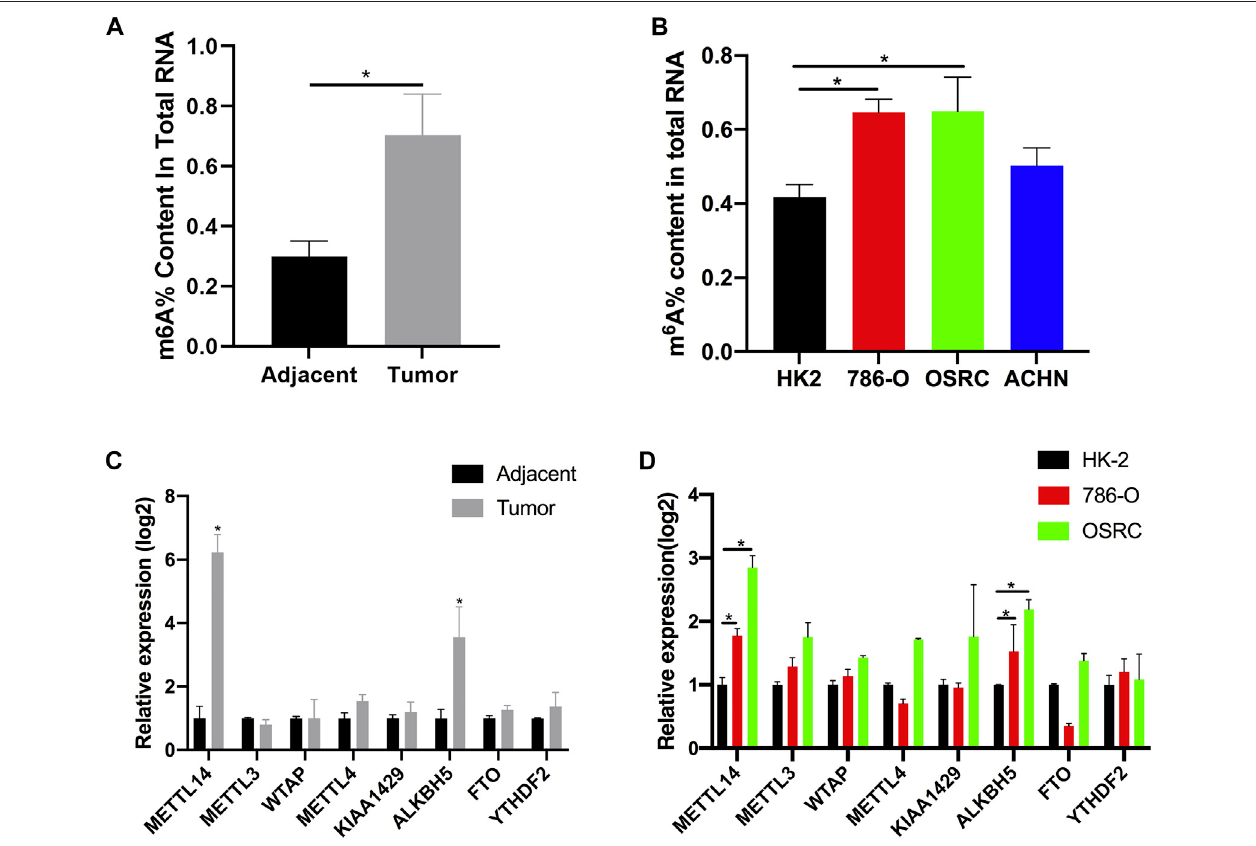
FIGURE 1 | The N 6 -methyladenosine (m 6 A) contents and modi fi cation enzymes expression in renal cell carcinoma (RCC) tissues and RCC cells. (A) The m 6 A contents of total RNAs in tumor and adjacent tissues ( n (cid:1) 5). (B) The m 6 A contents of total RNAs in normal renal cell line (HK-2) and RCC cell lines (786-O, OSRC, and ACHN). (C) The mRNA expression levels of m 6 A modi fi cation enzymes in RCC and adjacent tissues ( n (cid:1) 5). (D) The mRNA expression levels of m 6 A modi fi cation enzymes in normal renal cell line (HK-2) and RCC cell lines (786-O and OSRC). * p <